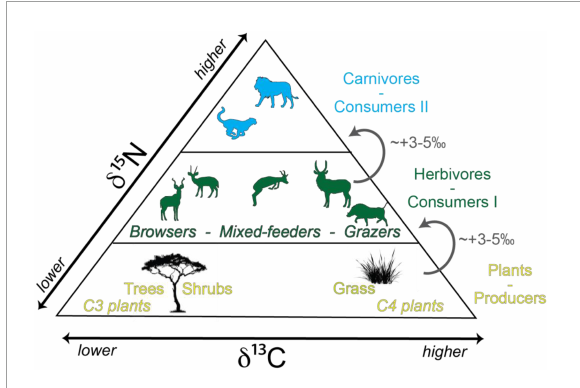
FIGURE1 Simplified summary of variations in δ 13 C and δ 15 N values in an African terrestrial food web. Modified after Bocherens